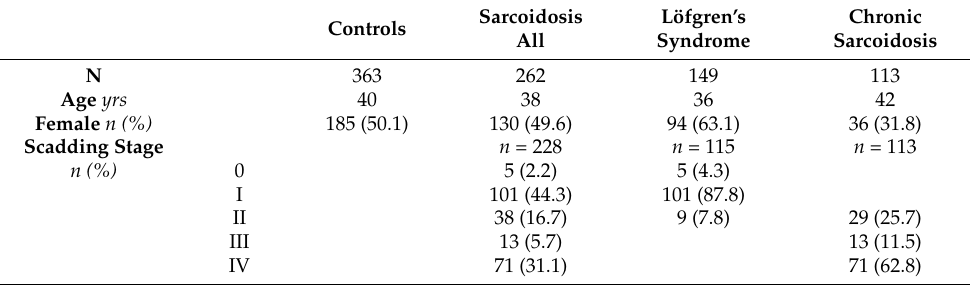
Table 1. Baseline characteristics of patients with Löfgren’s syndrome and chronic